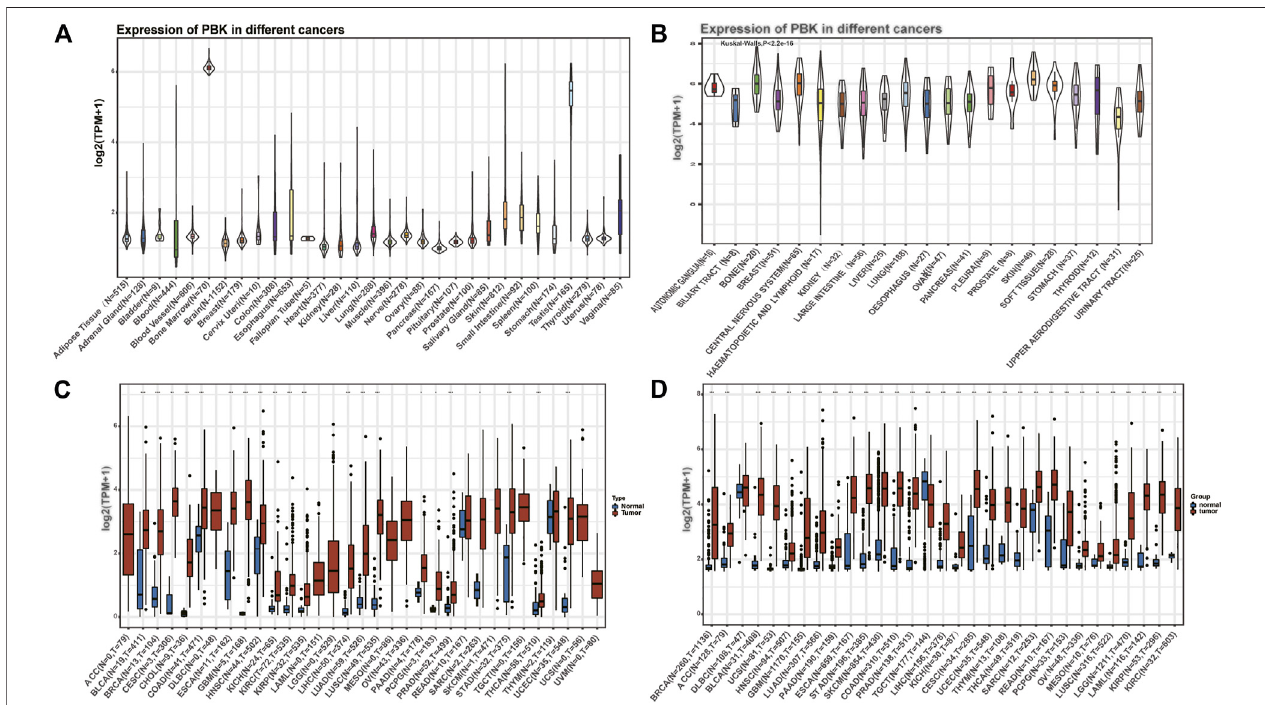
FIGURE1|| PBKisabnormallyexpressedinpan-cancer. (A) PBKexpressionin31tissuesfromtheGTExdatabase. (B) PBKexpressionin21tumorcellsfromthe CCLE database. (C) Differential expression of PBK in cancers and normal tissues from TCGA database. (D) PBK is abnormally overexpressed in 30 cancer types from the GTEx database and TCGA database (* p < 0.05, ** p < 0.01, *** p <